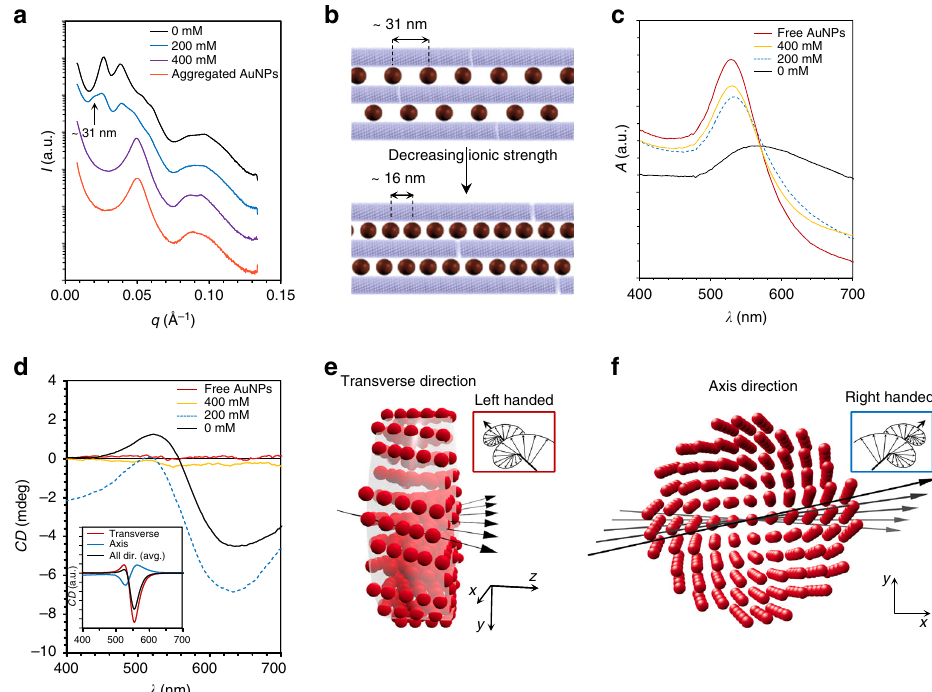
Fig. 4 Optical properties as a function of the superstructure. a SAXS data showing the formation of the superlattices upon decreasing ionic strength ( n AuNP / n TMV ~ 25 for all measured data). Data shifted in y -direction for clarity. The arrow indicates the diffraction peak ( q ~ 0.02 Å − 1 ) corresponding to the interparticle distance ( d ~ 31 nm) of nanoparticles within individual rows of nanoparticles. b Upon decreasing ionic strength, AuNPs are concentrated into the superlattice wires leading to a smaller AuNP interparticle distance. c UV – vis data (scaled for clarity) at different salt concentrations showing the effect of AuNPs assembling tightly in the superlattice as a function of the ionic strength. The plasmonic resonance peak at 524 nm corresponding to free AuNPs disappears completely only at low ionic strength. d CD data (Savitzky – Golay fi ltered for clarity, original data in Supplementary Fig. 12). CD features appear as the superlattice forms upon decreasing ionic strength. Inset shows the simulated CD spectrum for different directions of light propagation and taken as an average of all directions. e , f The generated nanoparticle model including 400 AuNPs used to model the CD spectrum. The fi gure indicates that the lattice undergoes a left-handed e or a right-handed f twist depending on the viewing